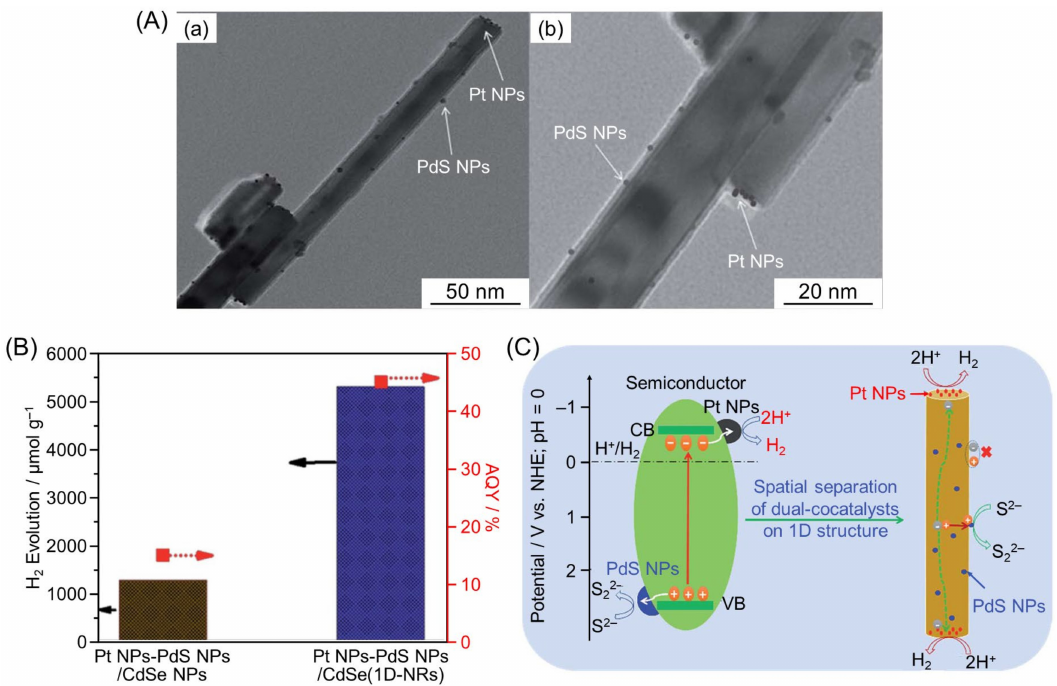
Figure 36. ( A ) TEM images of Pt NPs-PdS NPs/CdSe 1D nanorods (CdSe(1D-NRs)). Images ( a ) and ( b ) are at different magnifications. ( B ) Comparative H 2 evolution of Pt NPs-PdS NPs/CdSe(1D-NRs) and Pt NPs-PdS NPs/CdSe NPs. Conditions: catalyst (100 mg), Na 2 S–Na 2 SO 3 aqueous solution (100 mL, 0.1 M), and Xe lamp light source (300 W) with an optical filter ( λ > 420 nm). ( C ) Scheme of the proposed mechanism for photocatalytic H 2 evolution on CdSe(1D-NRs) with spatial separation of dual cocatalysts. Reproduced with permission from reference [289]. Copyright 2019 The Royal Society of